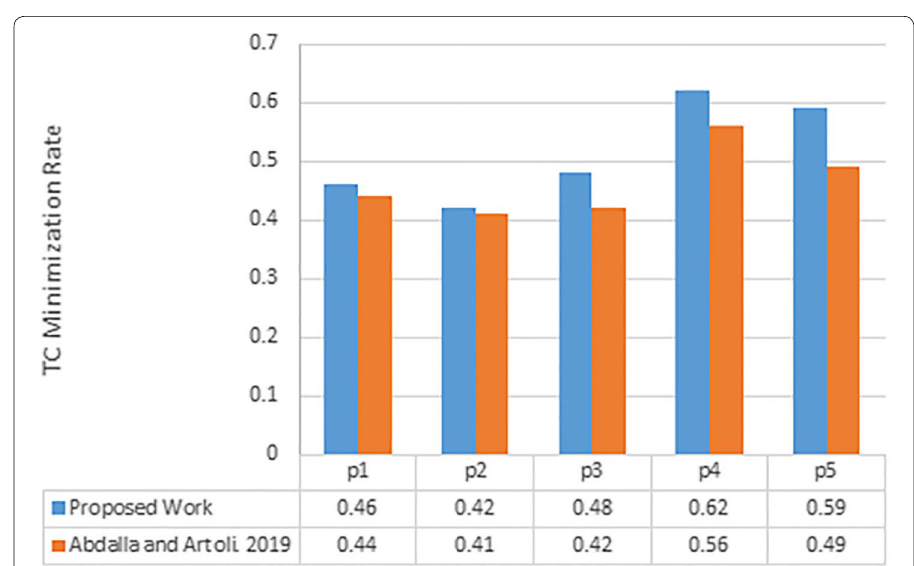
Fig. 9 Scenario 3—TC minimization in percentage: take the average TC over all